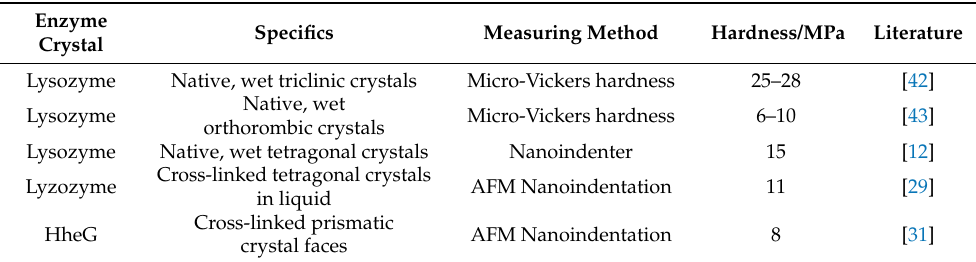
Summary of the hardness results for the native and cross-linked lysozyme and HheG